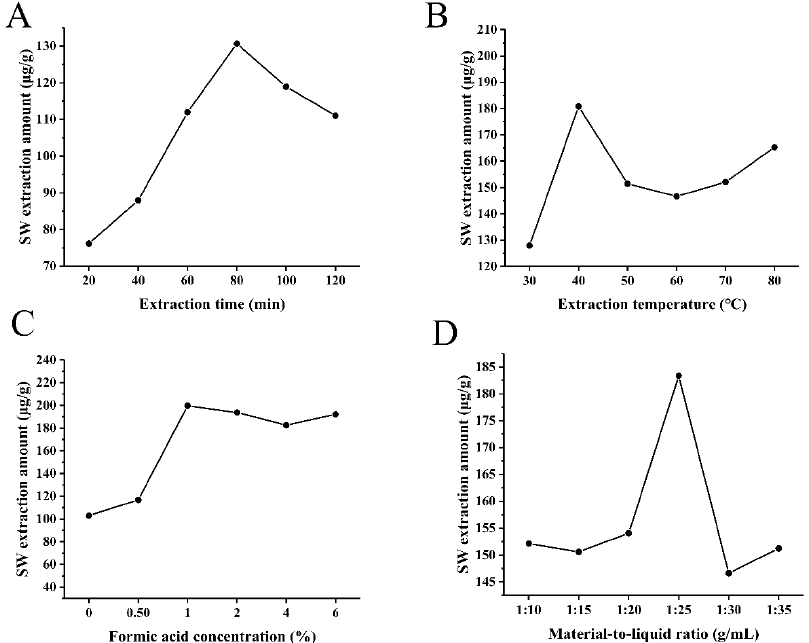
Figure 2. Results of single-factor test. ( A ) The effect of extraction time on SW extraction amount.